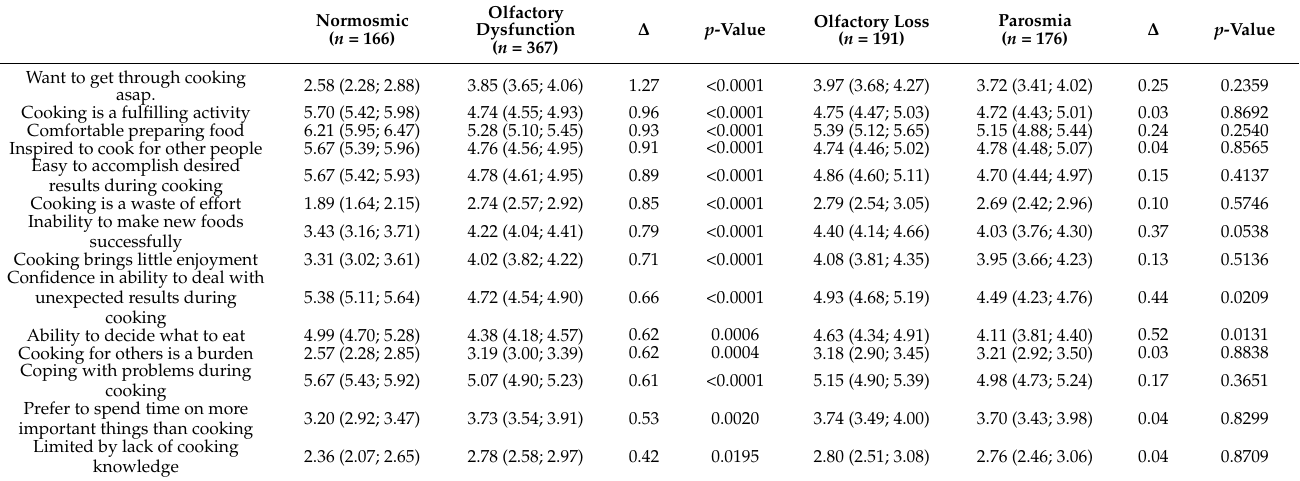
Table 2. Differences in cooking and food provisioning habits between normosmics and patients with olfactory disorders. Listed according to differences between normosmic controls and olfactory dysfunction, in descending order, where the largest differences are at the top. Mean values (95% CI) on a 1-7 scale. ∆ = difference; asap = as soon as